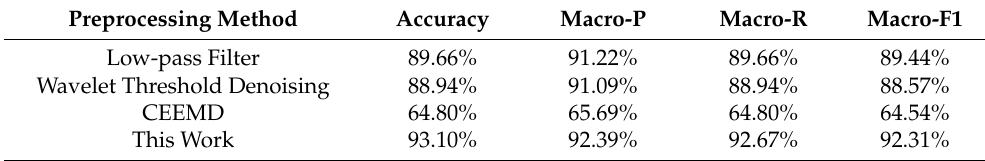
Table 4. Comparison of Classification Performance of Different Preprocessing